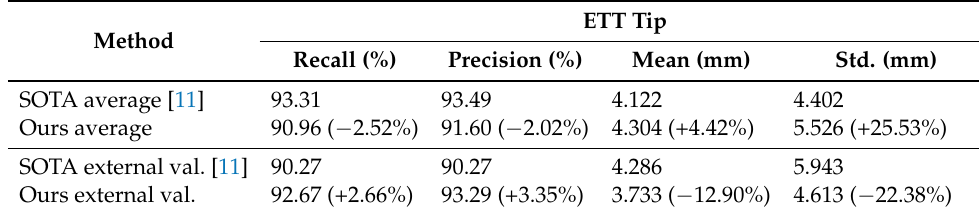
Table 11. The comparison results of recall, precision, and object error on the ETT tip.